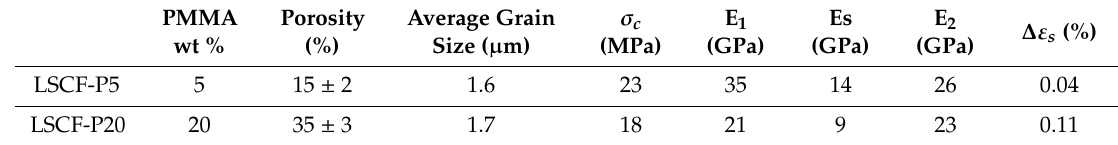
Table 1. Sample preparation conditions, porosity and ferroelastic mechanical parameters.